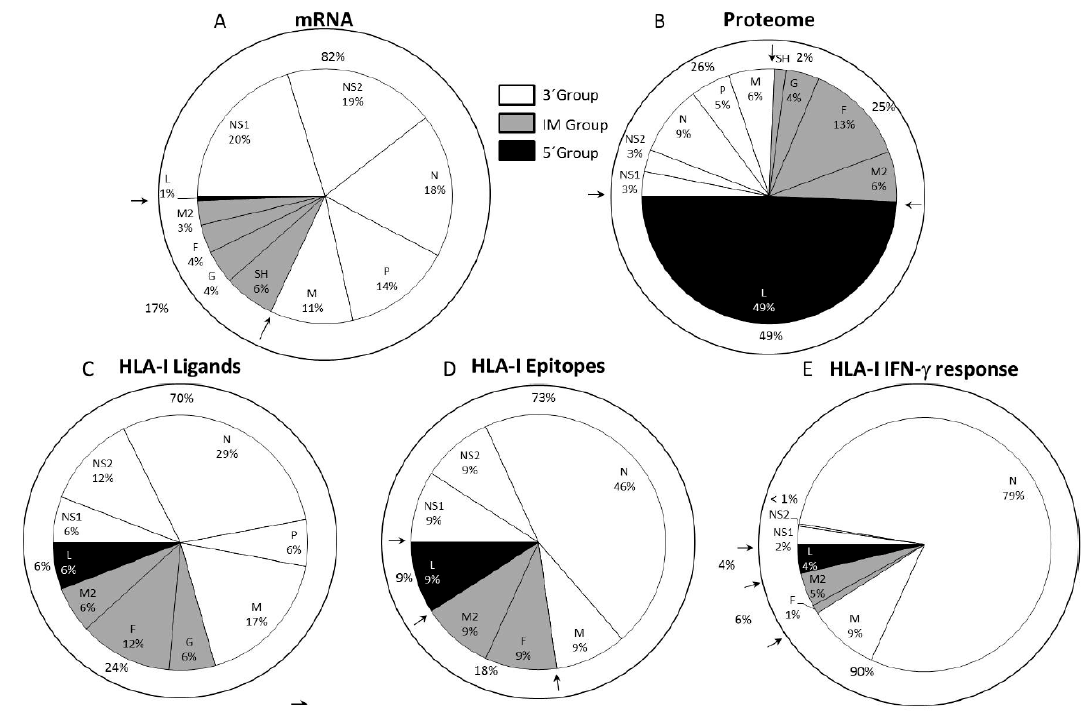
Figure 2. HLA class I ligands from HRSV identified by mass spectrometry and their relation to the viral mRNA, proteome, and T cell cytotoxic immune response. A panel: Pie chart representation of the HRSV genome indicating the relative abundance of mRNAs from the viral transcription, which was measured as the mRNA molar ratio percentage [21,41,42]. The abbreviations used for viral proteins were NS1 (non-structural protein 1), NS2 (non-structural protein 2], N (nucleoprotein), P (phosphoprotein), M (matrix protein), SH (small hydrophobic protein), G (glycoprotein), F (fusion protein), M2-2 (matrix protein 2], and L (polymerase), which were grouped into three different transcription groups: 3´ (white), intermediate (IM) (gray), and 5´(black) separated by arrows as in previously publications [21,41,42]. For each protein included into its respective transcription group, the proteome percentage is shown in B panel; the HLA class I ligand percentage identified by mass spectrometry in studies [35–38] is shown in C panel; the CTL epitope percentage from [37] is shown in D panel, and the total IFN- γ + immune response percentage detected in the HLA class I-transgenic mice from [37] is shown in E panel.